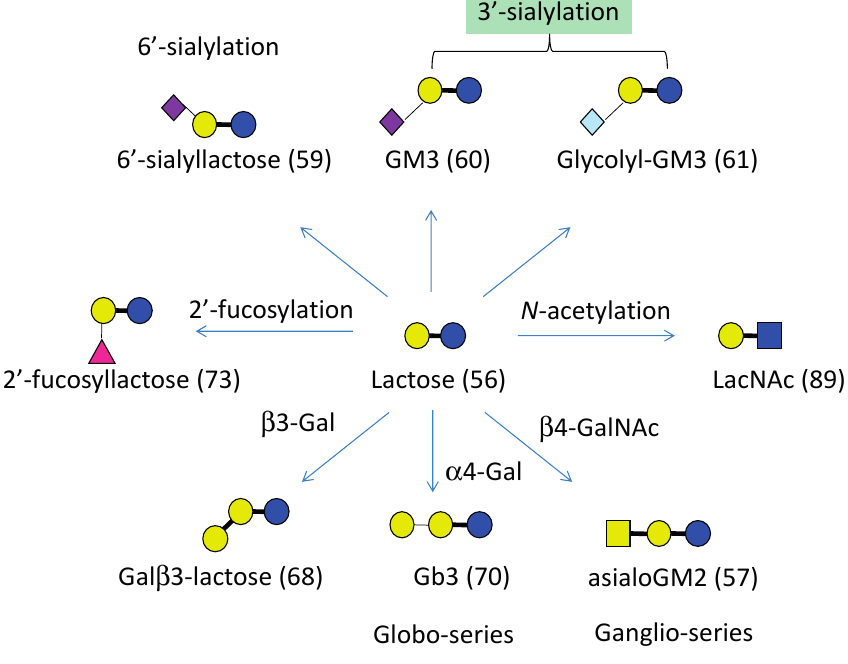
Figure 6. Lactose and its derivatives with “One Parameter”